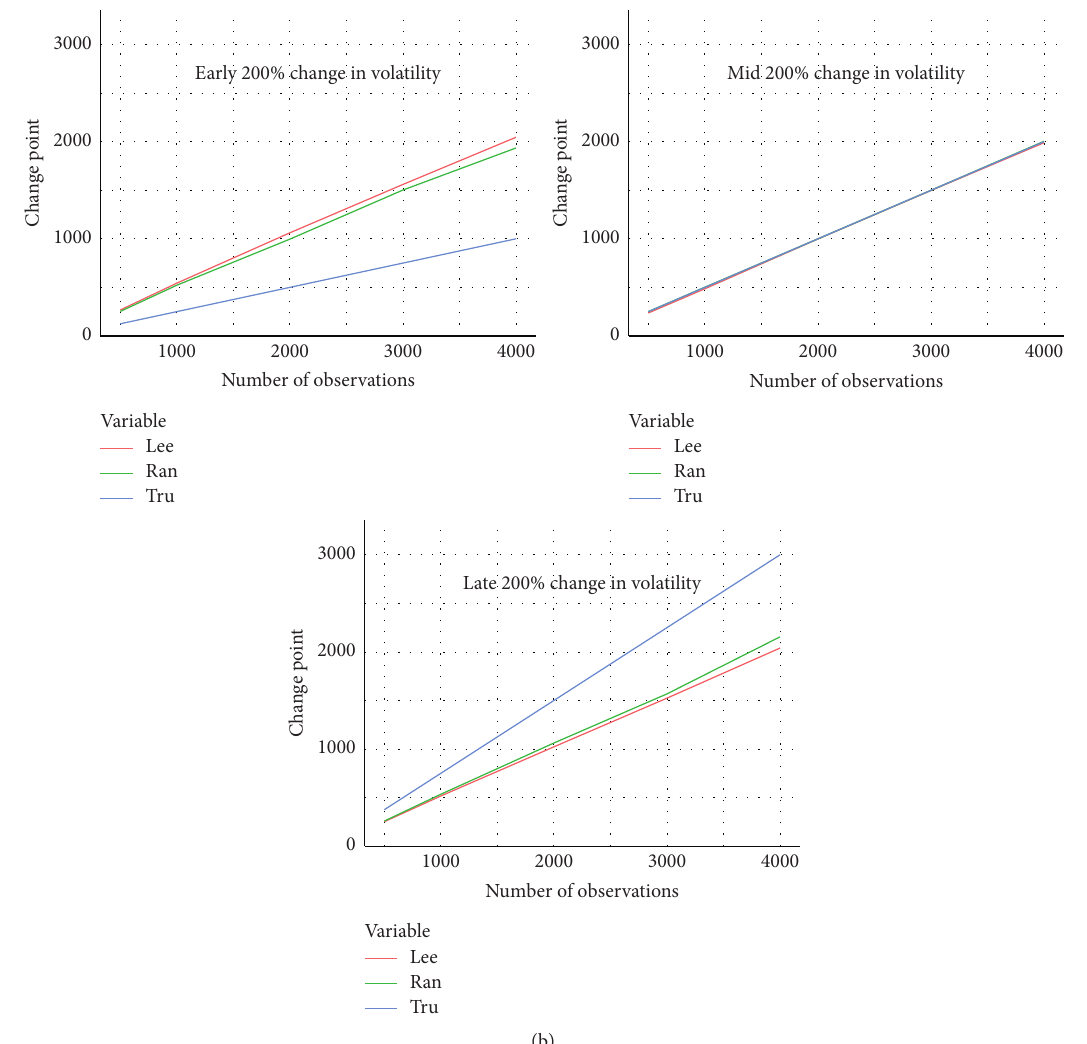
Figure 1: Graphs showing changes in volatility: (a) graph showing an early, middle, and late change with a 5% change in volatility of the True(Tru), ordinary CUSUM(Lee) of [20], and the Randomised(Ran) estimator and (b) graph showing an early, middle, and late change with a 200% change in volatility of the True(Tru), ordinary CUSUM(Lee) of [20], and the Randomised(Ran)